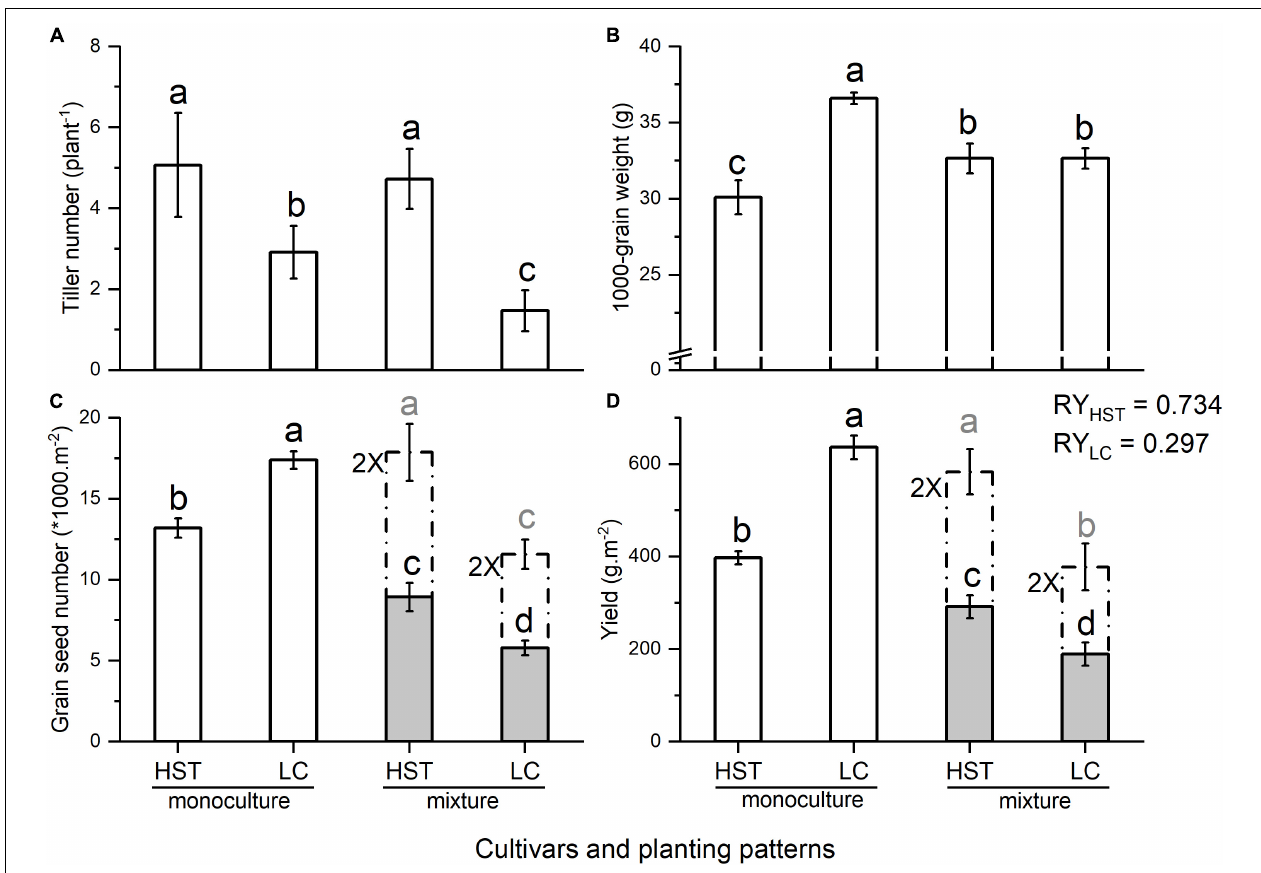
FIGURE 3 | Yield components in Field Experiment 2. (A) Tiller number; (B) 1,000-grain weight; (C) Grain seed number; (D) Yield. Error bars indicate one standard error above and below the mean. HST and LC are tested cultivars, RY: relative yield. Dashed bars represent doubling of the population variables for comparison